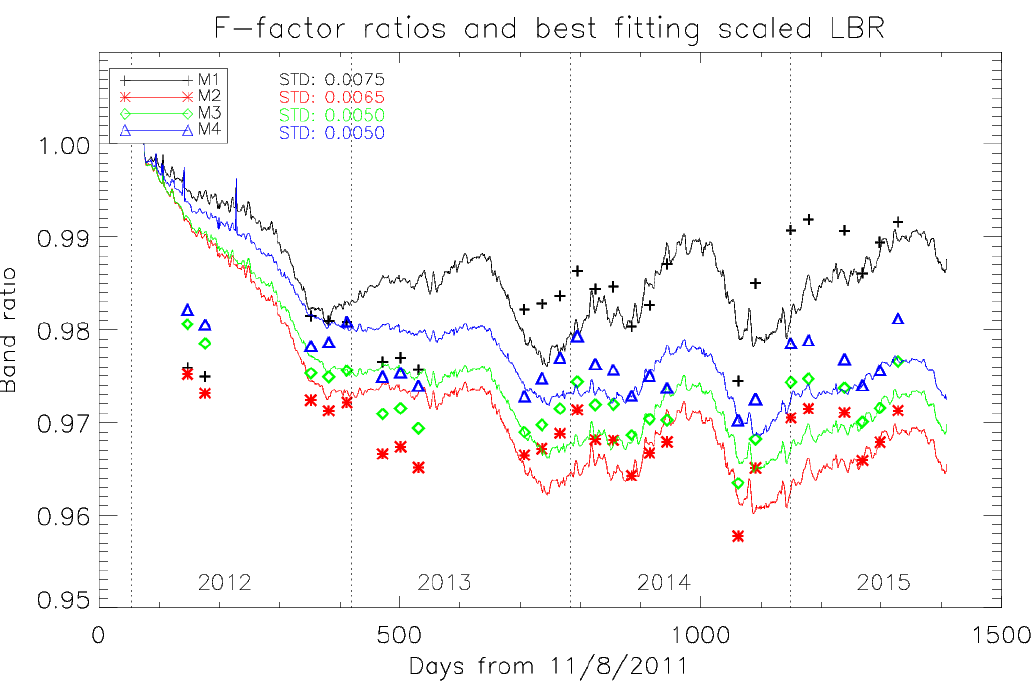
Figure 12. Normalized SD and lunar F-factor ratios in all RSB bands zoomed in M1 to M4 range.